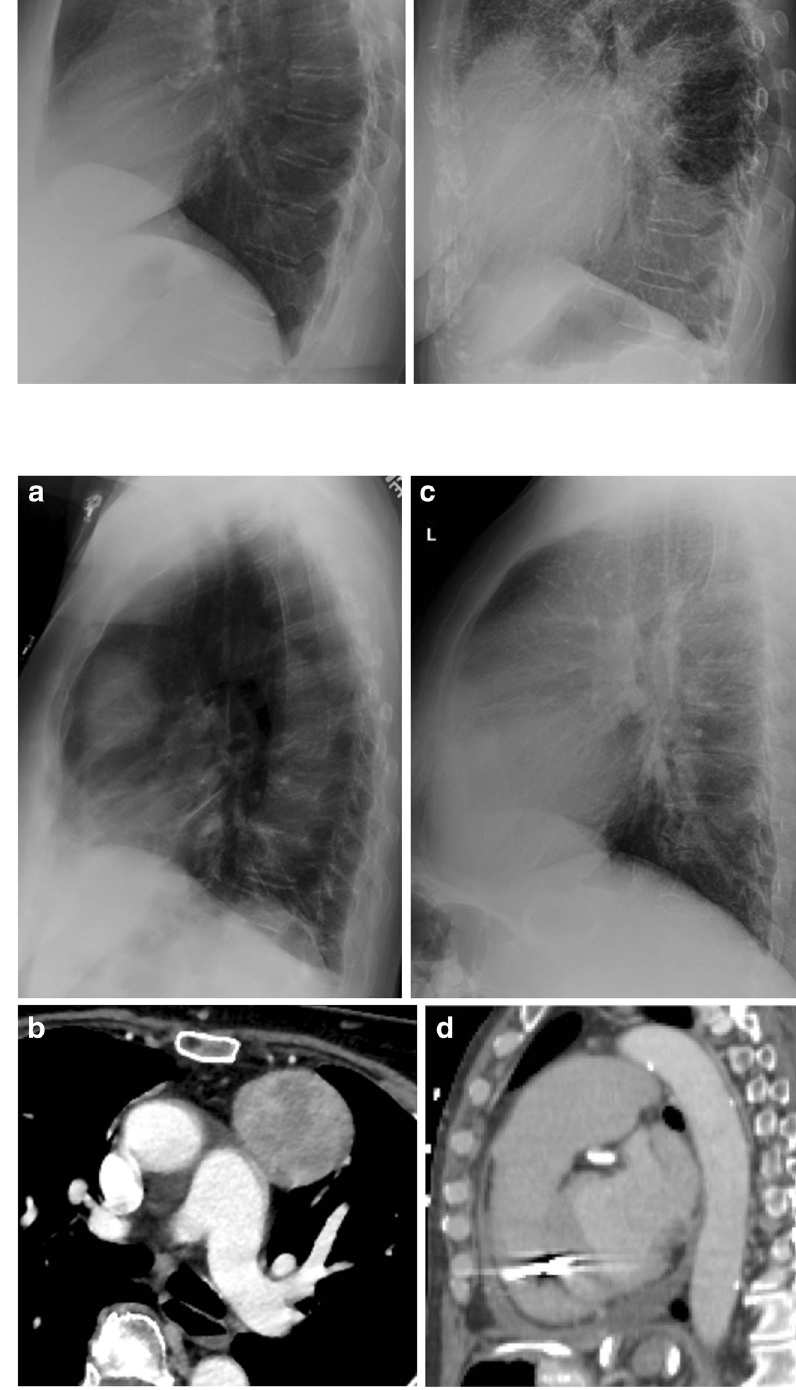
Fig. 1 Lateral chest radiographs demonstrating a normal retrosternal clear space (a), the lucent area between the sternum and ascending aorta, and retrosternal reticular opacities due to interstitial pulmonary oedema, known as B Kerley D lines ^